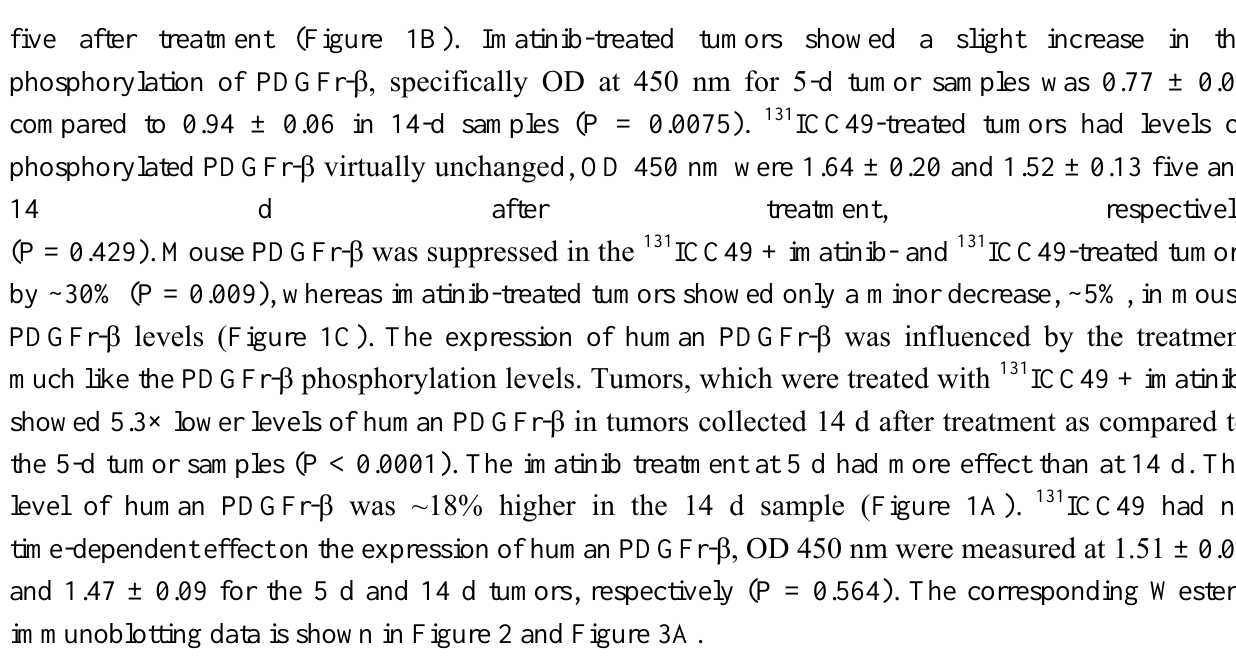
Figure 1. Expression of various forms of PDGFr-β in lysates prepared from SW1990 human pancreatic adenocarcinoma xenografts extirpated 5 d and 14 d after various treatments and measured using commercial ELISA kits. White bars represent the expression of PDGFr-β in tumors from control mice. Note different scales of the